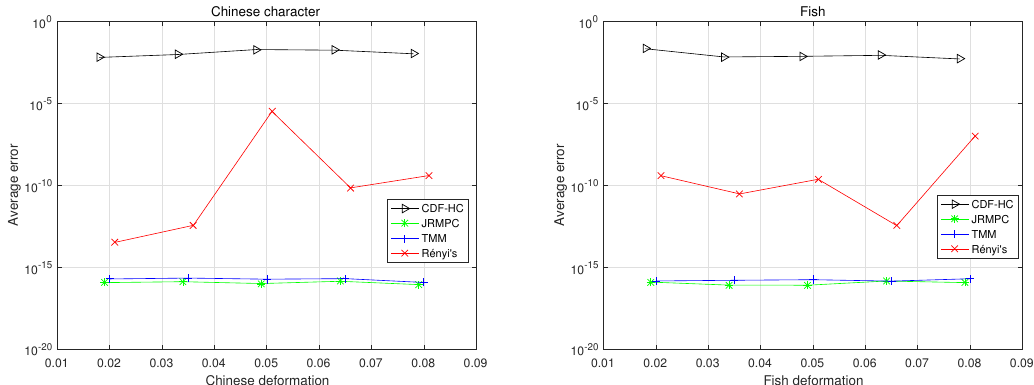
Figure 12. MSED, in log-scale, achieved from the application of the under-comparison group-wise registration algorithms on the Chinese characters set and fish shapes for different levels of degradation. Thus, from the results in the point set group experiment, the JRMPC and TMM algorithms present almost the same registration accuracy performance, but the JRMPC has lower computational load.